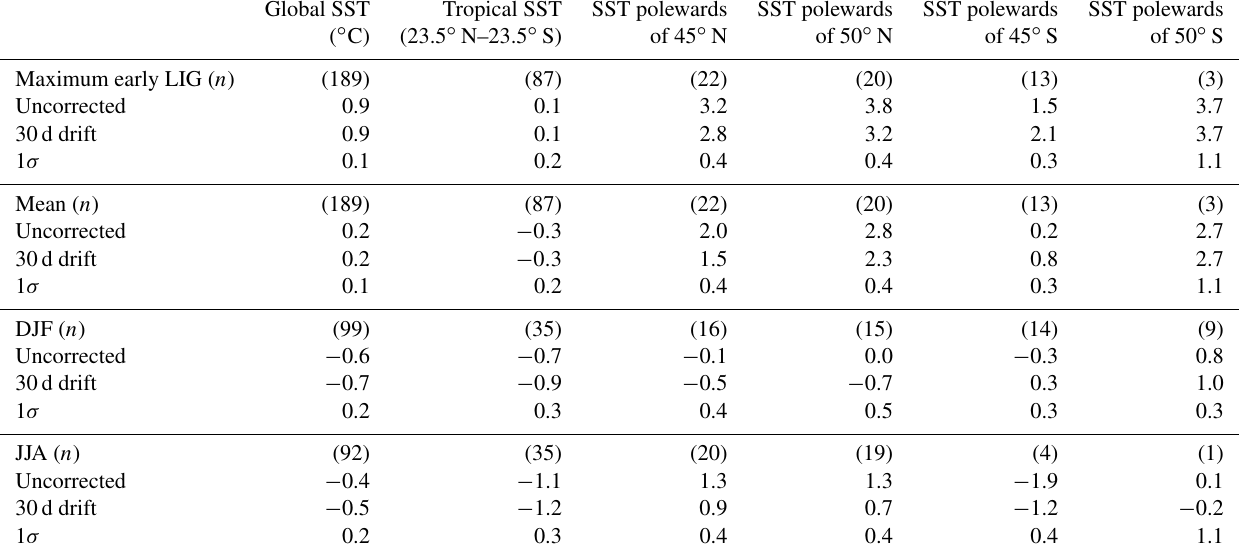
Table 1. Annual and seasonal temperature estimates for the Last Interglacial. DJF: December to February; JJA: June to August. Temperature anomalies relative to the period 1981–2010CE. Maximum early temperature is defined as the maximum annual temperature recorded during the estimated first 5 millennia of the Last